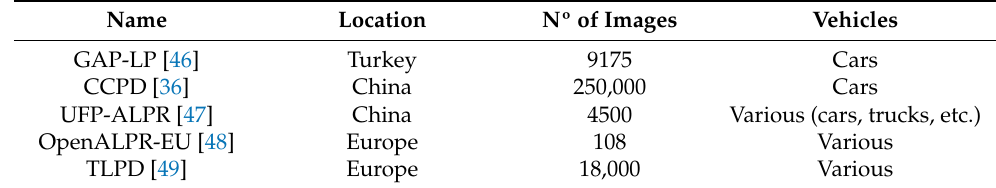
Table 2. Main license plate